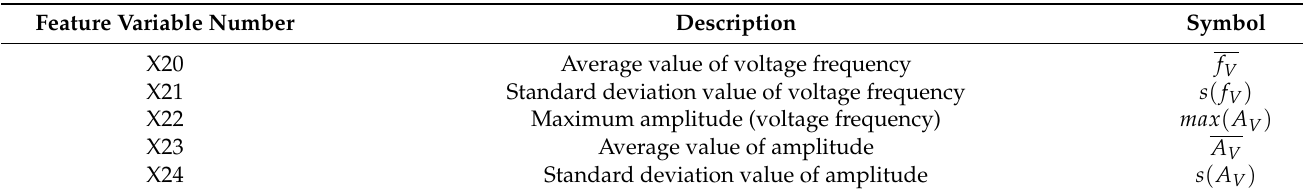
Table 4. D efinitions of feature variables. Table 4. Cont.